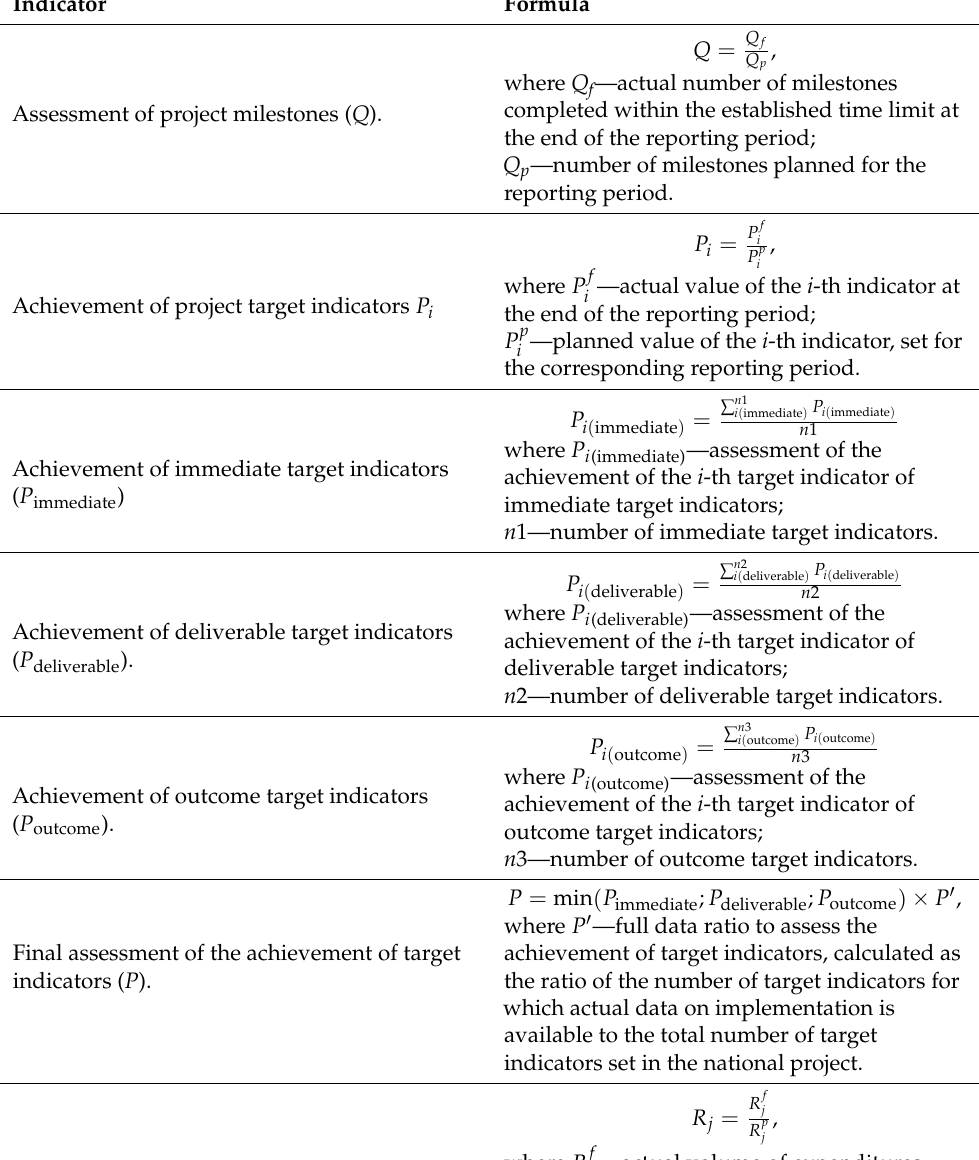
Table 2. Recommended methodology for analyzing the achievement of expected results of an institutional project.